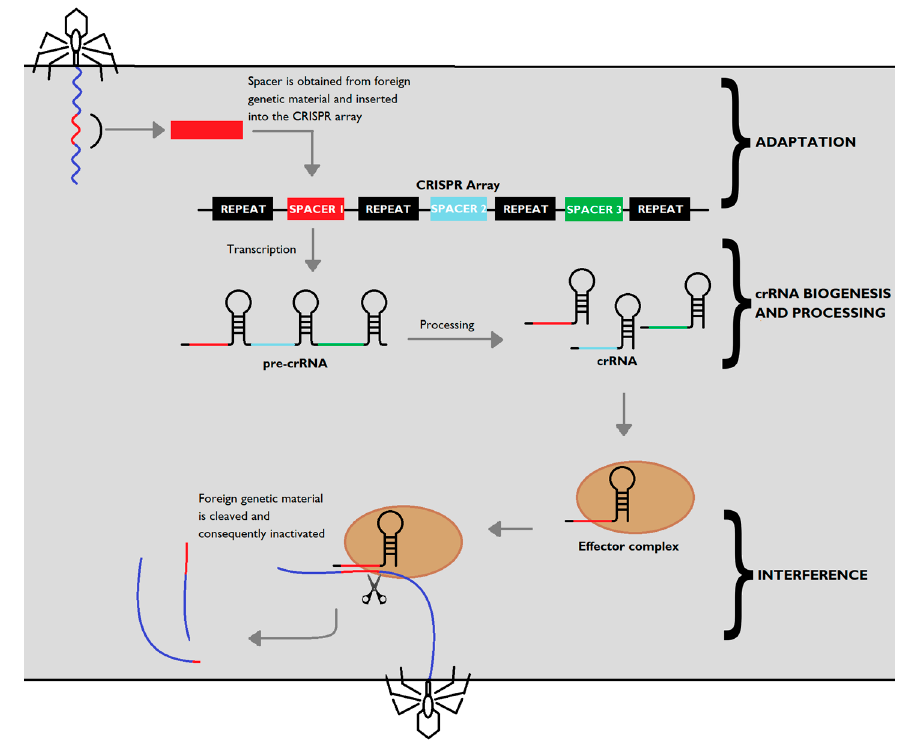
Figure 1. CRISPR-Cas adaptive immunity. Upon injection of genetic material from a virus or a plasmid into the bacteria, part of the invading sequence is cleaved and incorporated into the CRISPR locus, forming a new spacer within the locus. The CRISPR array is transcribed into a precursor to crRNA molecules (pre-crRNA), which is then cleaved into mature crRNA, which form effector complexes with type-specific Cas proteins (brown). When a foreign sequence matches a CRISPR spacer, the matching crRNA binds to the invading strand, activating Cas proteins with nuclease activity which silence the